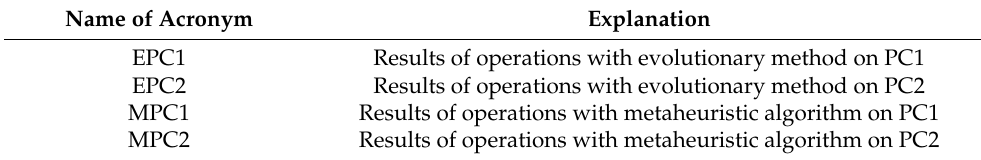
Table 5. Definitions of abbreviations used.